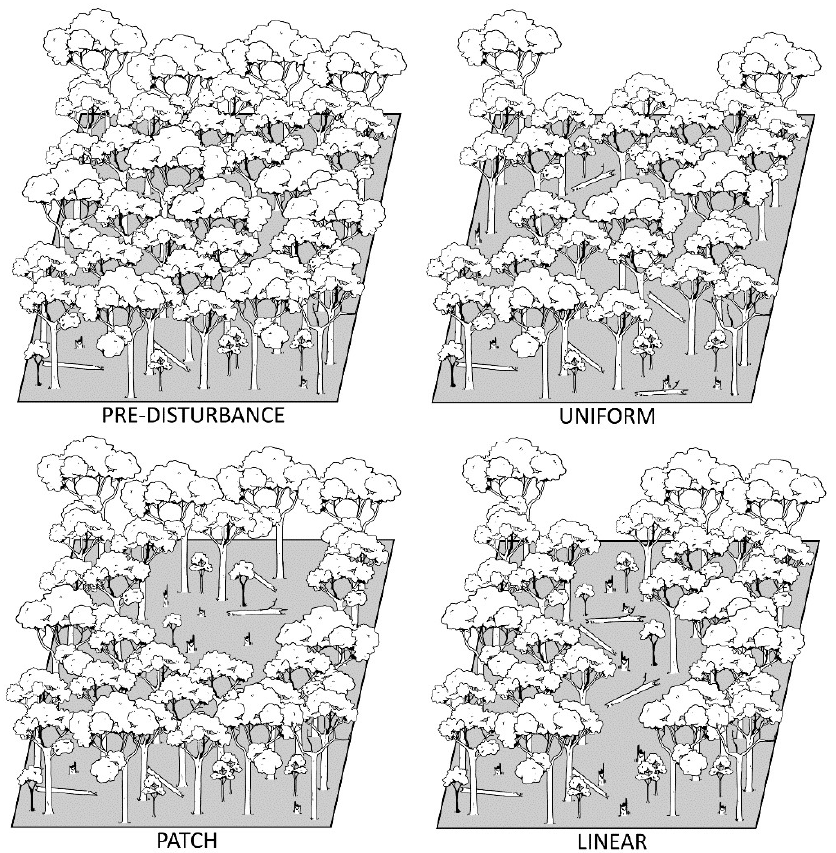
Figure 2. Spatial patterns of mortality and residual trees after intermediate-severity disturbance. The pre-disturbance condition represents a mature, deciduous broadleaf dominated stand prior to intermediate-severity disturbance. In the uniform pattern, canopy trees were removed relatively evenly throughout. The patch pattern shows clustered mortality and the linear pattern shows stems removed in a strip. In each disturbance pattern depicted, seven canopy trees (ca. 25% reduction in canopy tree density from the pre-disturbance depiction) were removed.